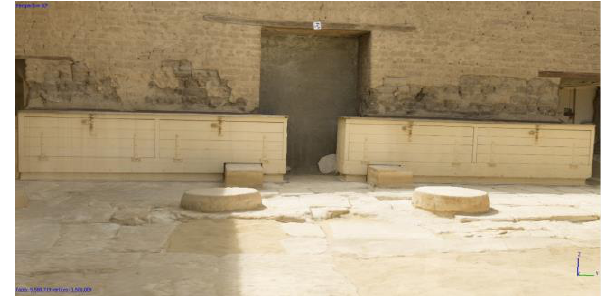
Figure 6. View of the 3D model of the tomb of Maya showing the wooden lockers located in the second courtyard, as surveyed (elaboration by F Fiorillo, 2018).